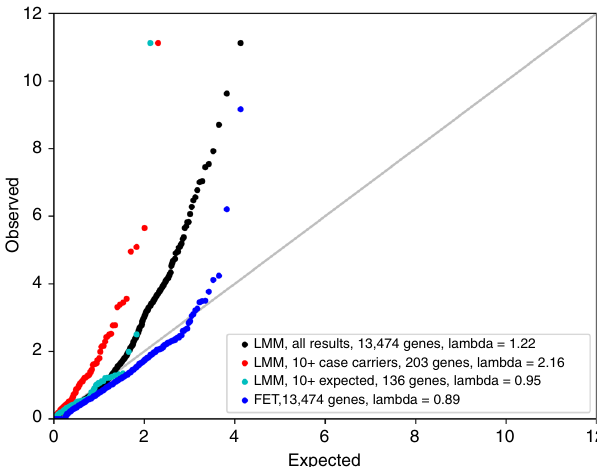
Fig. 3 Overlaid QQ plots for the coding model with the phenotype atrial fi brillation. This phenotype has a 1:22 case:control ratio. Shown are the results for a linear mixed model (LMM) meta-analysis of all European ancestry individuals with no minimum number of variant carriers required (black), with at least ten case carriers observed (red), and with at least ten case carriers expected in the case group based on the overall frequency (cyan), as well as a Fisher ’ s exact test (FET) of unrelated European ancestry individuals and all genes included (blue). The second to last condition is the requirement we set for our main analysis results. The one signi fi cant association is TTN , known from previous studies to be involved in phenotypes related to atrial fi brillation 28 . This association is signi fi cant (meta-analysis p < 3.4 × 10 − 10 ) in the LMM analysis, but it is dif fi cult to distinguish from test statistic in fl ation without using the 10 expected case carriers cutoff (cyan). There is no in fl ation in the Fisher ’ s exact test of unrelated individuals, but this association is not signi fi cant in that